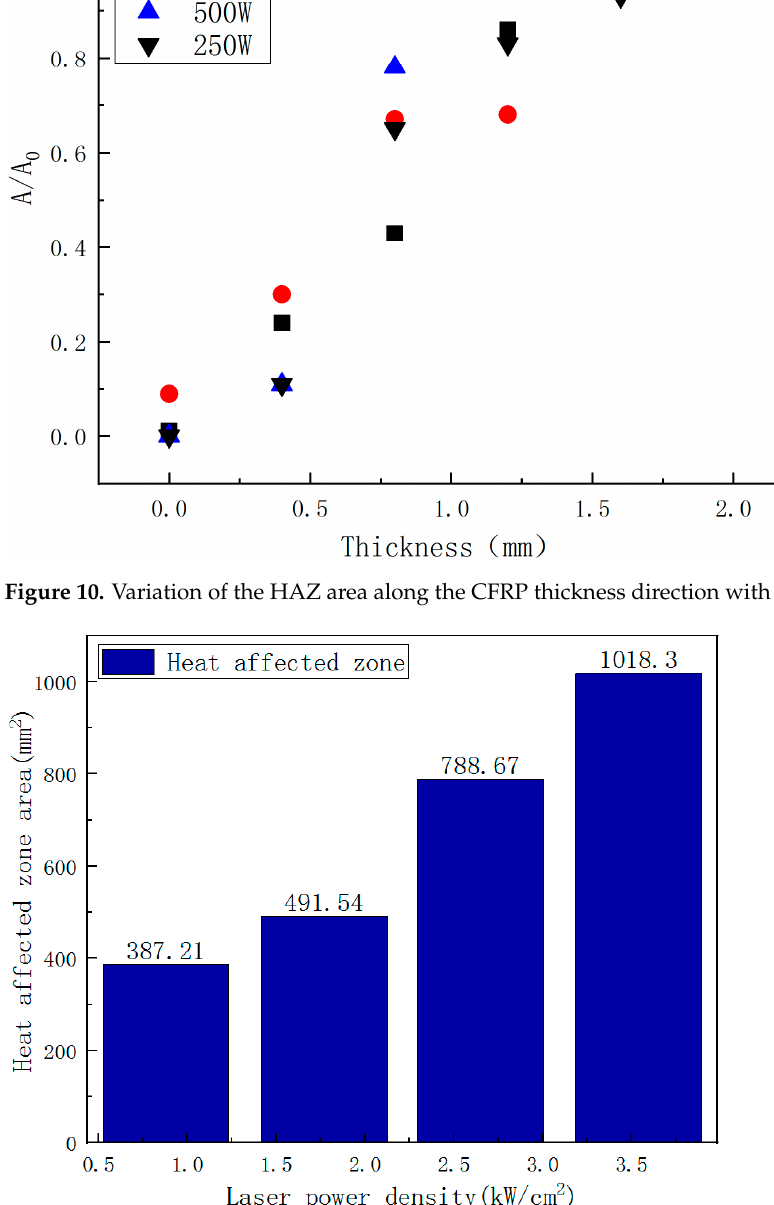
Figure 11. Variation of the HAZ area with different laser power densities.